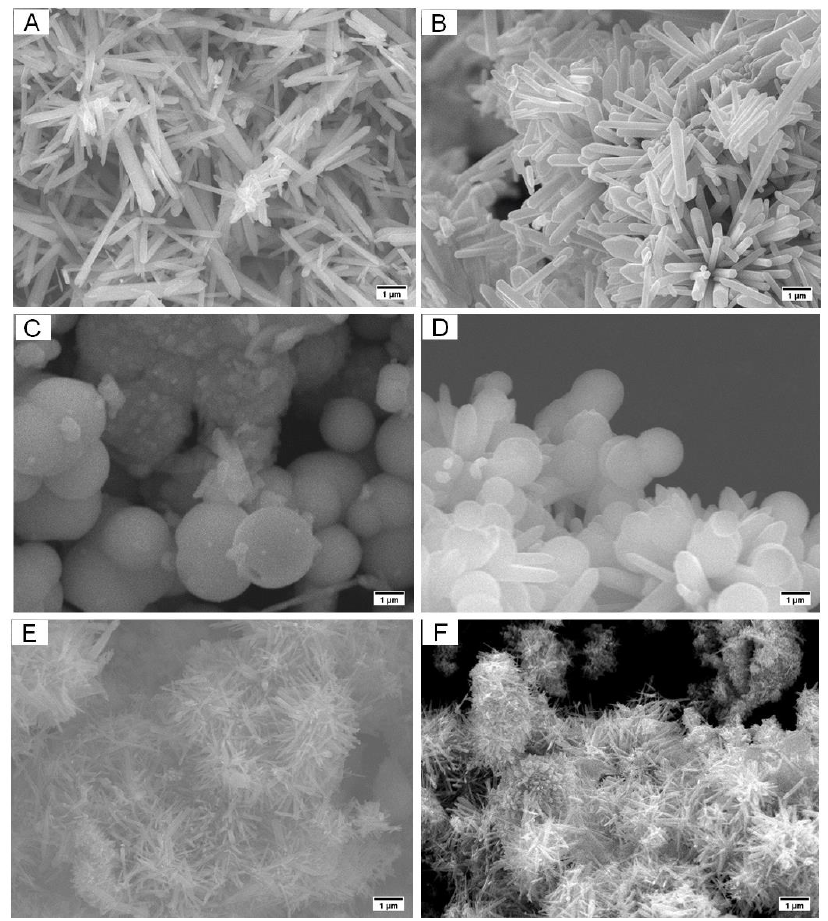
Figure 1. SEM images of ZnSe nanostructures: ZnSe nanorods ( A , B ), nanospheres ( C , D ) and nanoclusters ( E , F ). The phase purity, crystallographic structure and crystal formation of zinc selenide was investigated via wide-angle XRD analysis within the range of 5 – 80° (Figure 2A).